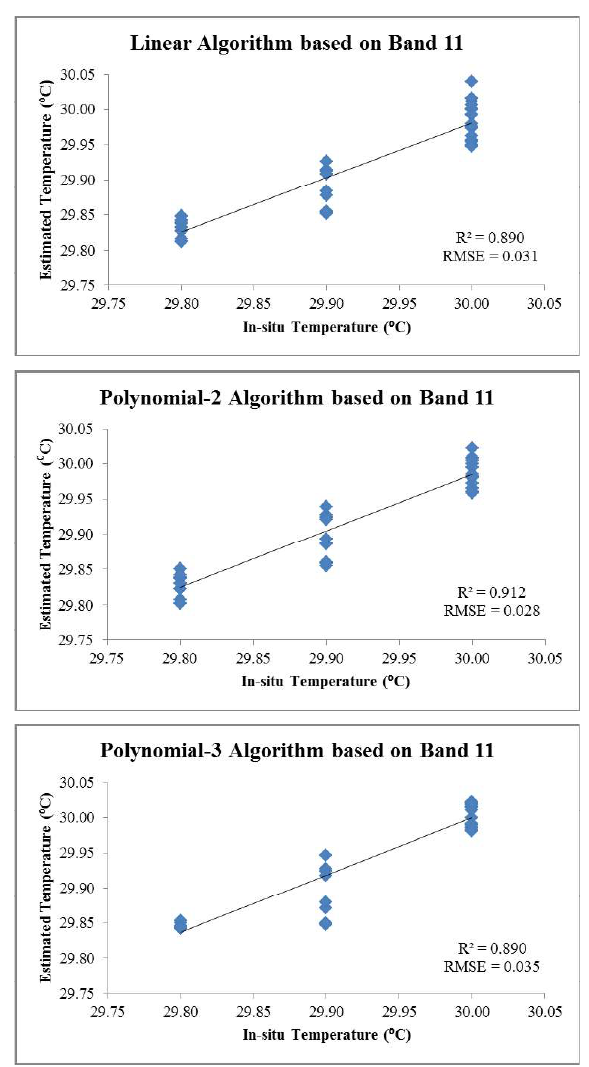
Figure 7. Band 11 Sea Surface Temperature Algorithms Performance The algorithm based on band 11 polynomial-2 with coefficient of -0.0197, 0.2881, and 29.004 had a good performance. It could be seen by its R 2 and RMSE value. The R 2 is 0.912 and the RMSE is